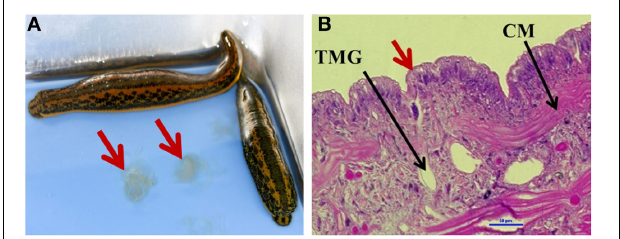
FIGTREE v.1.4.0 (http://tree . bio . ed . ac . uk/software/figtree/).